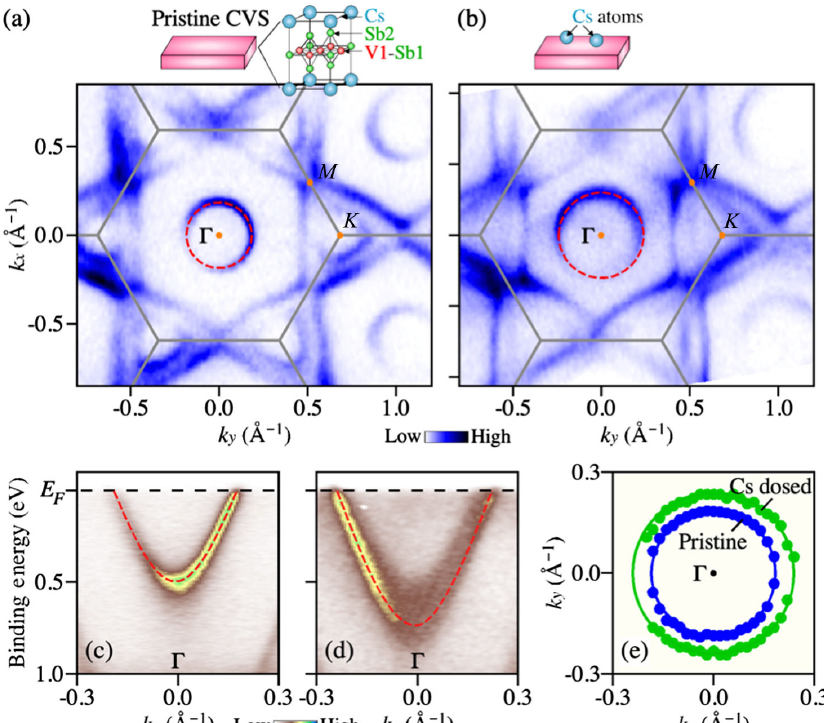
FIG. 1. (a),(b) ARPES-intensity map at E F plotted as a function of k x and k y measured at T ¼ 120 K (above T photons (corresponding to the k z ∼ 0 plane) for pristine CVS (pristine) and moderately Cs-dosed (Cs) samples, respectively. The inset of (a) shows the crystal structure of CVS. (c),(d) Comparison of the ARPES intensity around the Γ point between pristine and Cs samples. (e) Comparison of the k F points for the Γ -centered pocket between the two